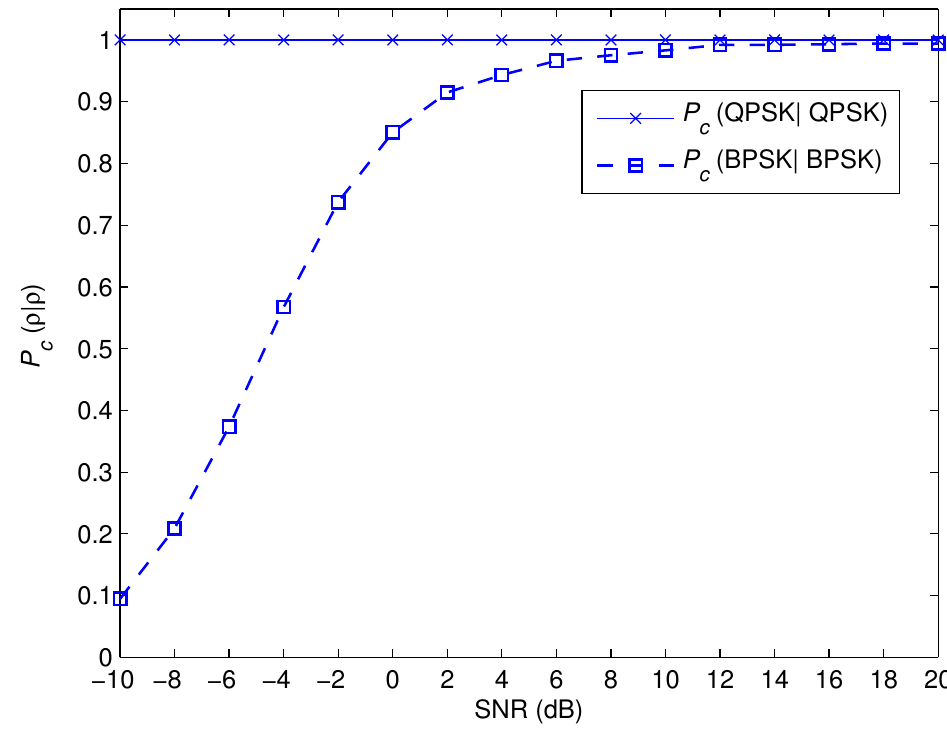
Figure 8. The categorization performance for the modulation set of Ω 1 .